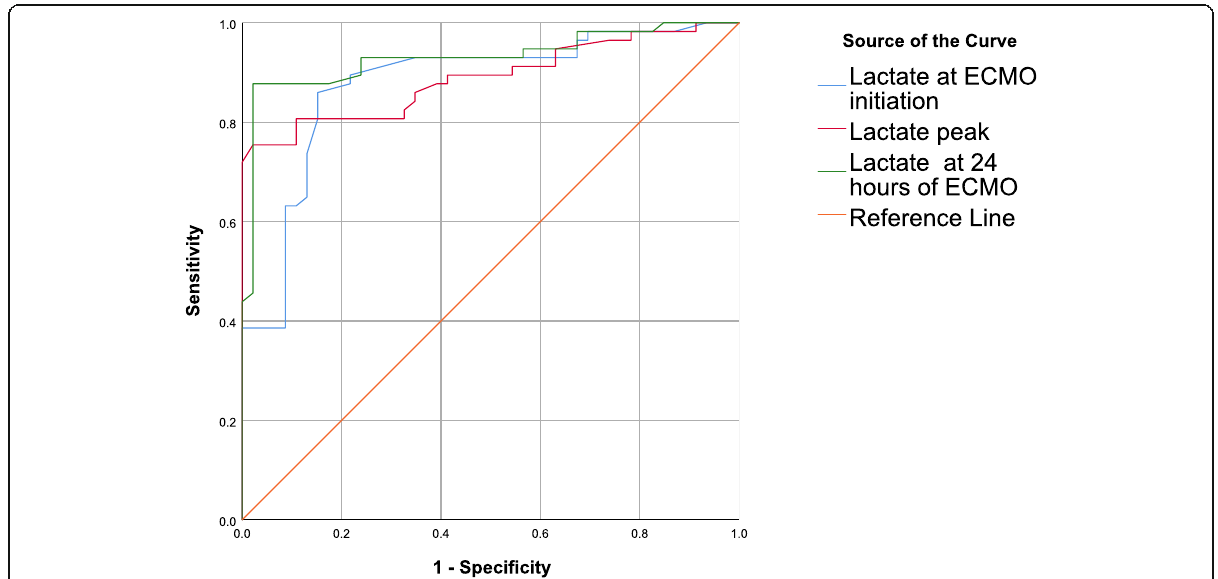
Fig. 2 ROC of blood lactate in differentiating mortality of VA-ECMO-treated